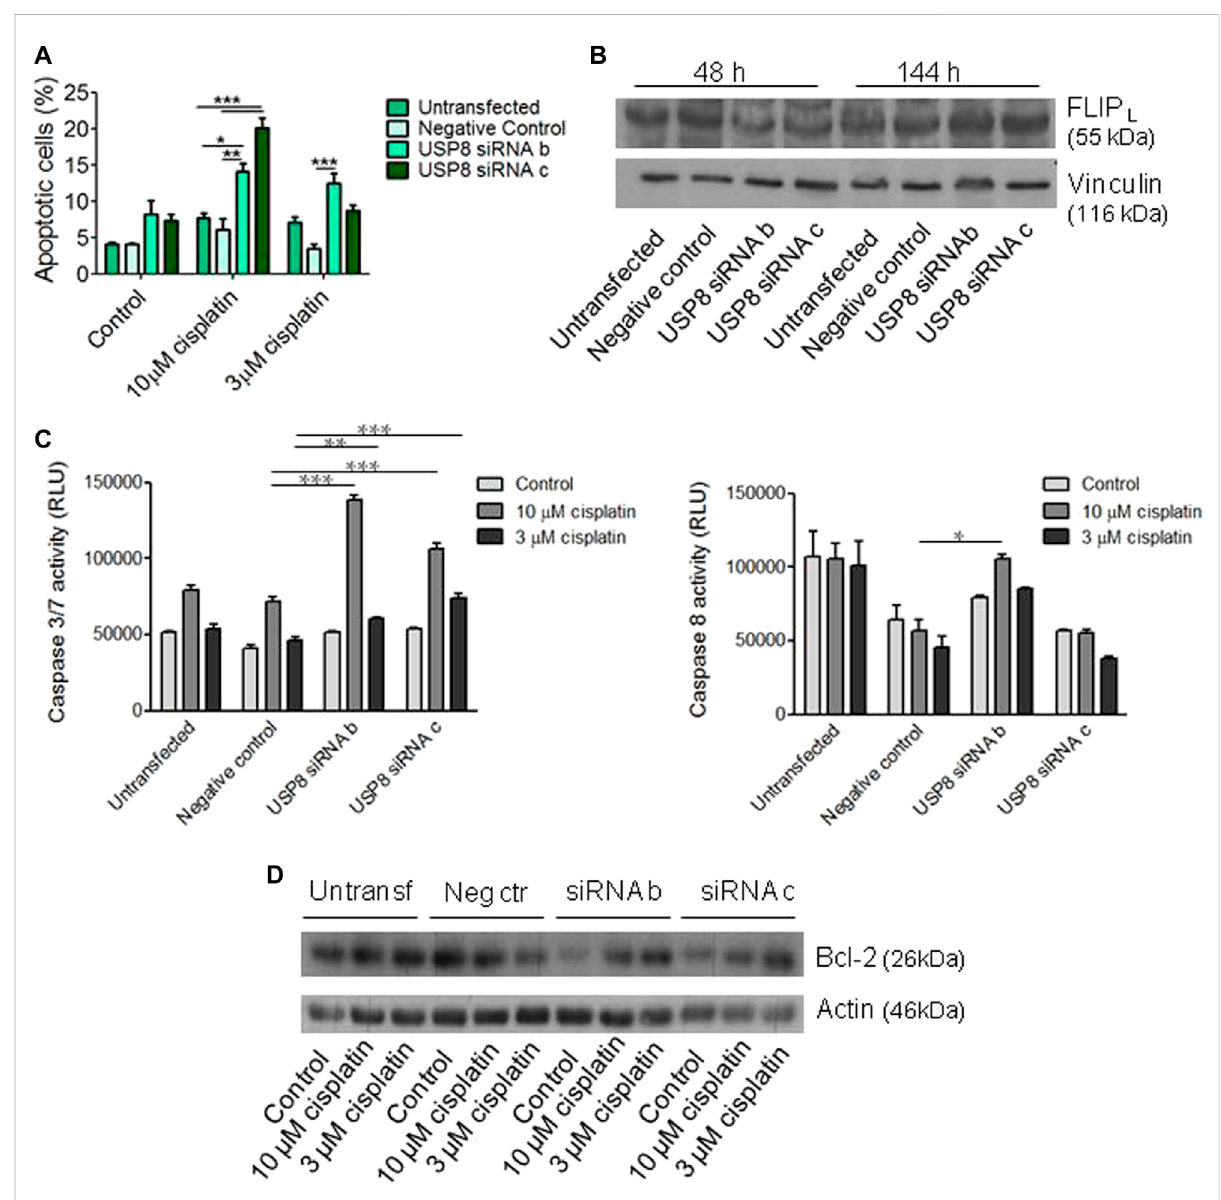
FIGURE 3 Analysis of apoptosis following USP8 molecular targeting in IGROV-1/Pt1 cells. (A) USP8-silenced cells were seeded for apoptosis analysis by Annexin-V binding assay 48 h after transfection start and treated for 72 h with cisplatin. The columns indicate late apoptosis (Annexin V-PI positive cells). One experiment representative of at least two is shown. (B) Western blot analysis of FLIP L protein levels in USP8-silenced cells. The band intensity was quanti fi ed using ImageJ and normalized to vinculin. The obtained values are reported in the Supplementary Figure S2 (C) Forty- eighthoursaftertransfection,cellswereseededforcaspase3/7andcaspaseeightactivationanalysisbyluminescentCaspaseGloassaysandtreated for48 hwithcisplatin.Oneexperimentrepresentativeofatleasttwoisshown.*, p < 0.05;**, p < 0.01;***, p < 0.001byOne-WayANOVAfollowedby Bonferroni ’ s test for multiple comparisons. (D) Western blot analysis of Bcl-2 was carried out in USP8-silenced cells seeded 48 h after transfection start and treated for 48 h with cisplatin. The band intensity was quanti fi ed using ImageJ, normalized to actin and the obtained values are reported in the Supplementary Figure